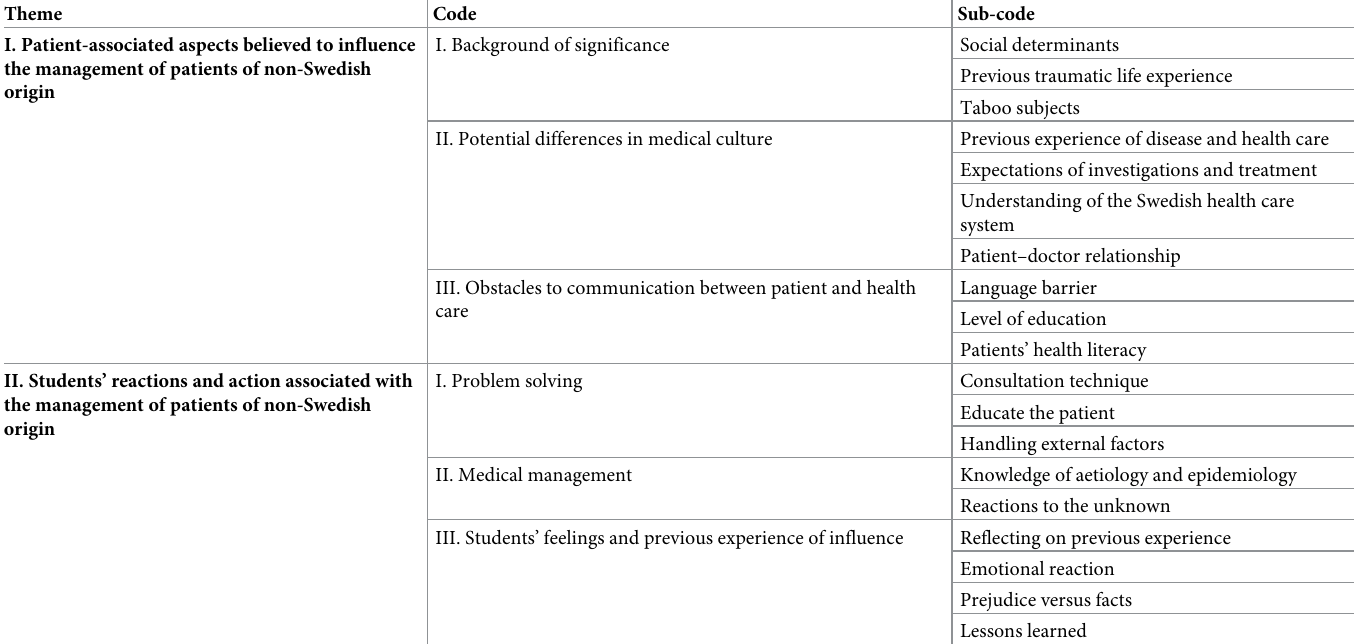
Table 2. Coding tree of the semi-structured